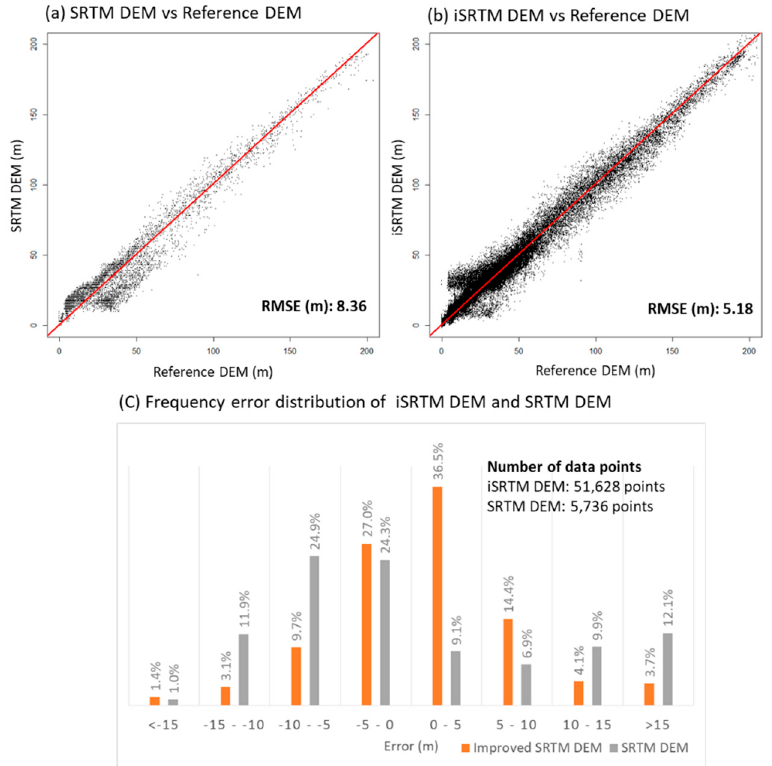
Figure 6. Scatter plots and RMSE comparisons between ( a ) SRTM DEM and ( b ) iSRTM DEM; ( c ) frequency error distribution comparisons in dense urban area in Nice.